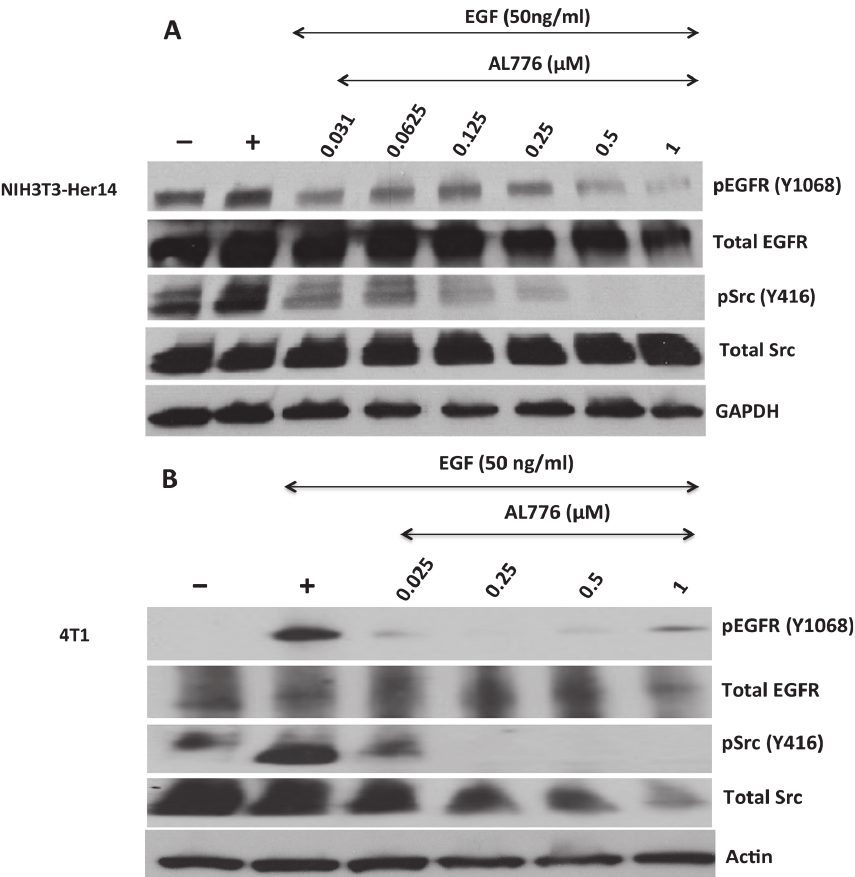
Fig 7. Target modulation using western blot analysis. ( A ) NIH3T3-Her14 (EGFR transfected cells) and ( B ) 4T1 mouse mammary tumour cells were starved using serum-free medium for 24h and treated with varying concentrations of AL776 for 2h. The drug was removed from the medium and the cells were stimulated with 50 ng/ml of EGF for 30 min. Cells were extracted, lysed and western blot analysis was carried out according to the protocol described in the Materials and Methods section. Membranes were probed with phospho-EGFR (Y1068), phospho-Src (Y416), total EGFR, Src and housekeeping (Actin or GAPDH)